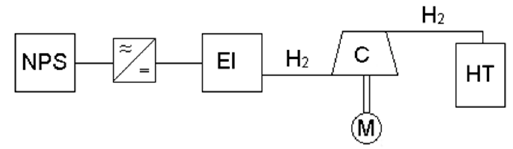
Figure 2. Flowchart: clean, grey hydrogen production system (El—electrolyzer; NPS—national power system; C—compressor; M—electric motor; and HT—hydrogen tank) [9].